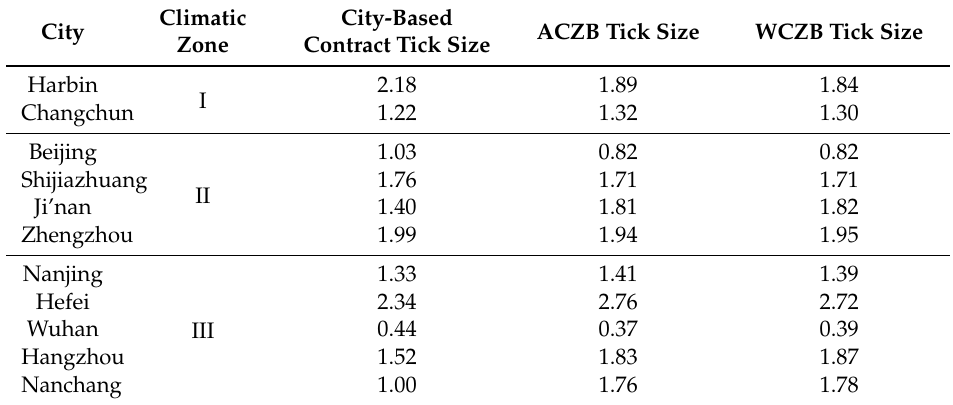
Table 3. Estimated tick sizes of city-based contracts, ACZB contracts and WCZB contracts (year: 2007). Climatic City